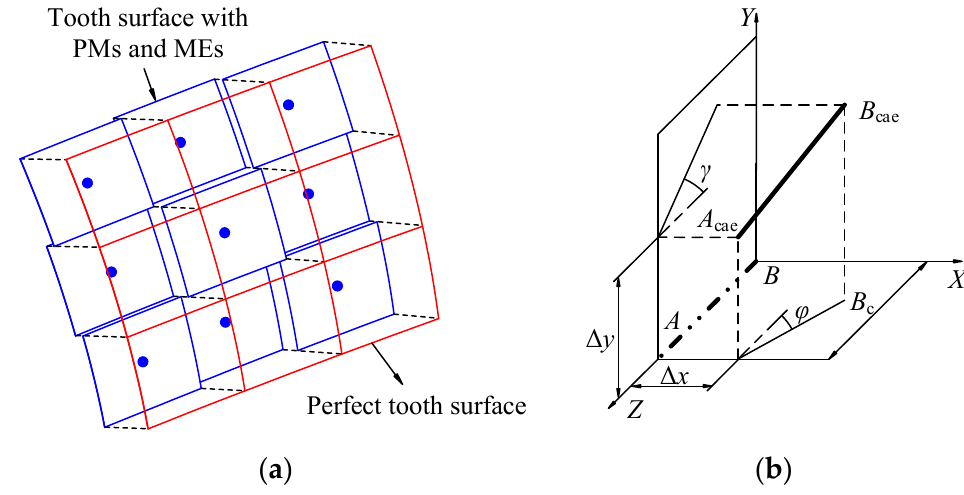
pitch deviation ( F p ). The part of the tooth surface of cycloid gear considering PMs and distances from the perfect tooth surface. Similarly, the tooth surface of the pin considering MEs has the same characteristics.